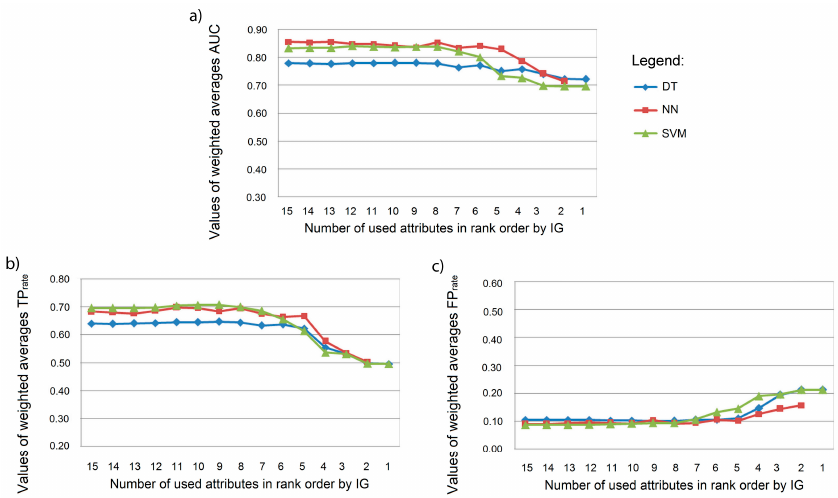
Figure 3. Effectiveness of the attribute selection when applied to building models based on weighted average of: ( a ) Area Under Receiver Operating Characteristic Curve (AUC); ( b ) True Positive rate (TP rate ); ( c ) False Positive rate (FP rate ).